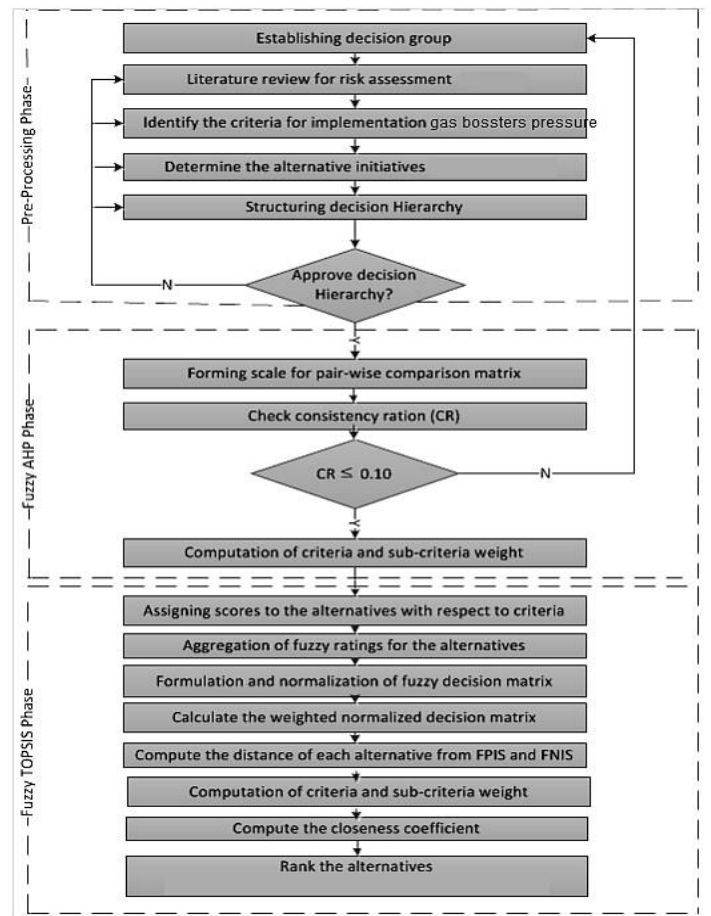
Figure 3. The model of research